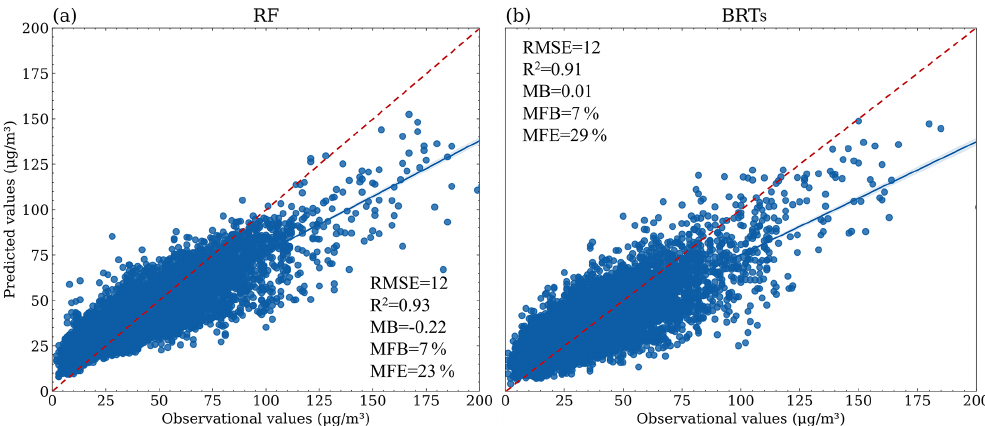
Figure 3. The performance of PM 2 . 5 predictions of the two machine learning methods in Guangzhou. (a) RF-deweathered; (b) BRT-